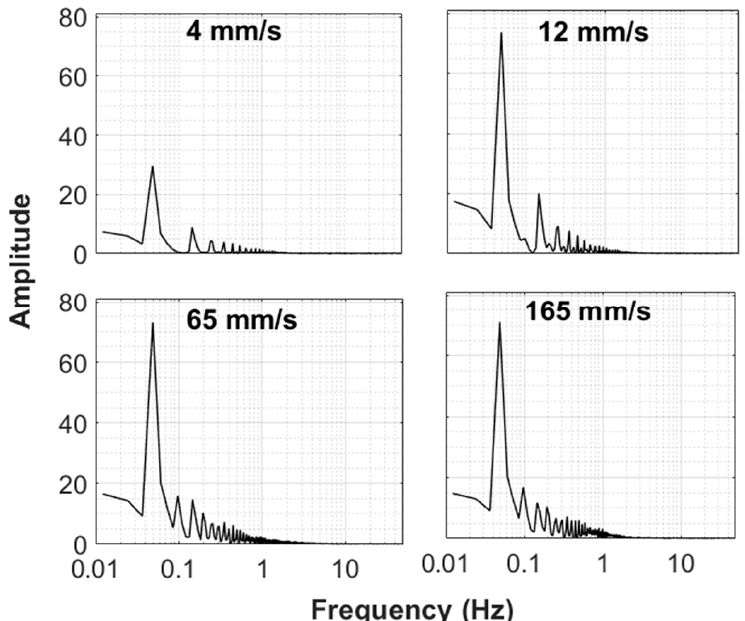
Figure 17. Frequency response of overall bed dynamics at di ff erent velocities of fluidization cycle for pulsed fluidization.